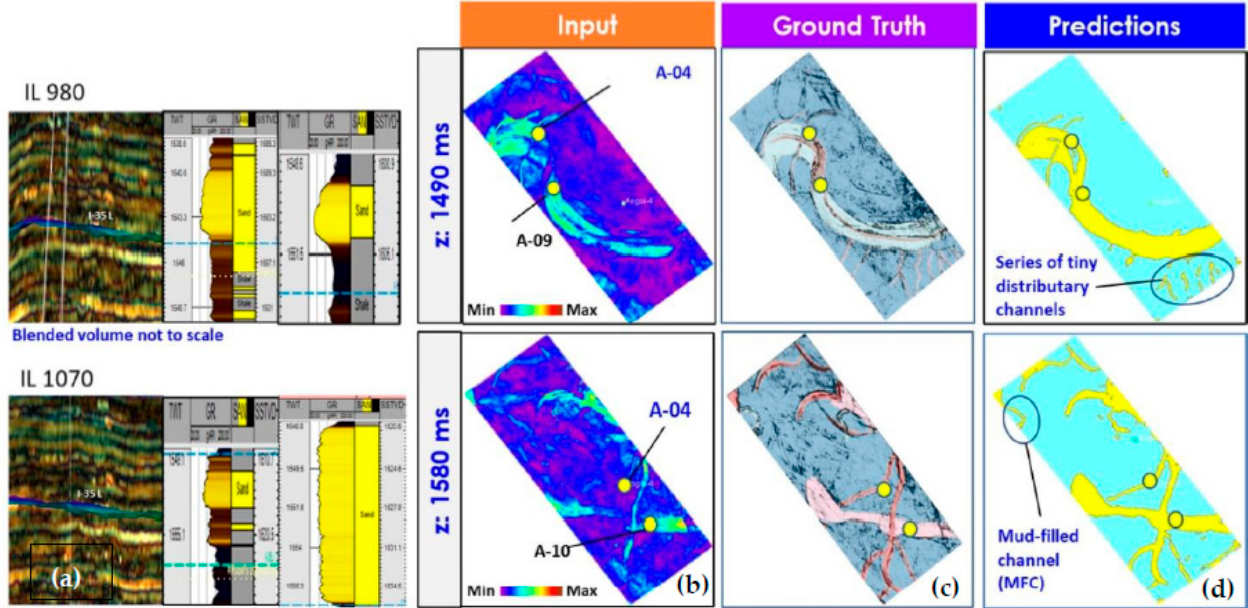
Figure 9. The results for binary facies classification in A Field. ( a ) Two random sections of blended spectral decomposition cubes passing through three key wells showing log pattern analysis in the channelized reservoir interval. Two different time slices in ( b ) portray comparisons between multi- attributes as the input (inset are the sweetness attributes). ( c ) The labeled data prepared by a human interpreter. Results from binary classification ( d ) show that the trained neural network is still capable of capturing Class III facies and distributary channels, as indicated in the ellipse, despite dealing with the challenge of imbalanced facies.